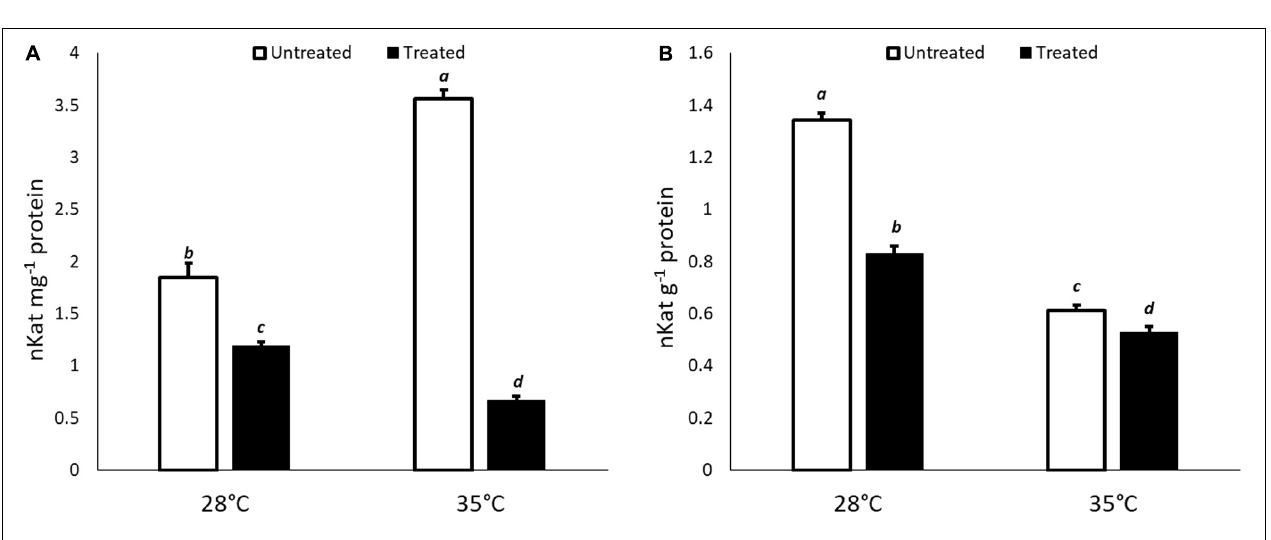
FIGURE 4 | Effect of KIEM R (cid:13) on ICL enzymatic activity at 24 (A) and 48 h (B) after seed incubation. Values are expressed as nKat mg − 1 protein. Bars represent the mean ± SD of three different biological replicates. For each bar, different lowercase letters indicate significant differences ( p ≤ 0.05), as measured by one-way ANOVA followed by Tukey’s post hoc